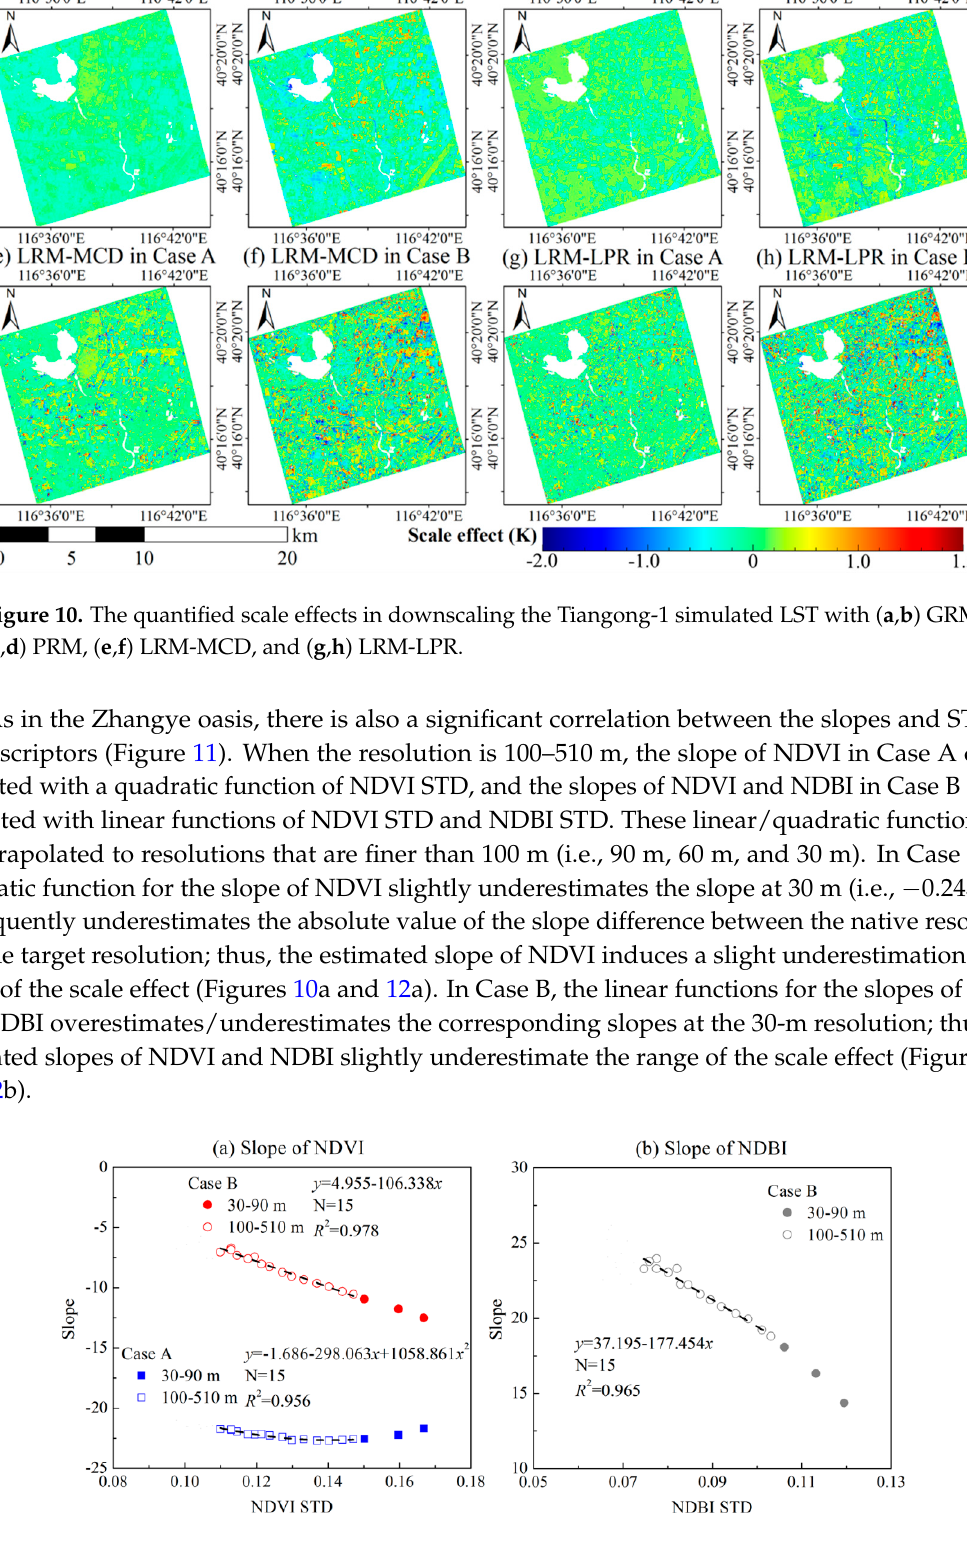
Figure 11. ( a , b ) The relationship between the slopes of the LST-descriptors functions and the STDs of the descriptors in Beijing city. The regressions are significant at the 0.001 level. The LSTs were simulated from the Tiangong-1 LST on 30 July 2013.